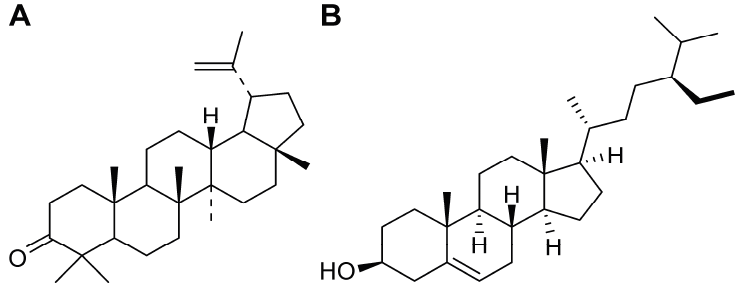
Figure 1. Chemical structure of lupenone ( A ) and β -sitosterol ( B